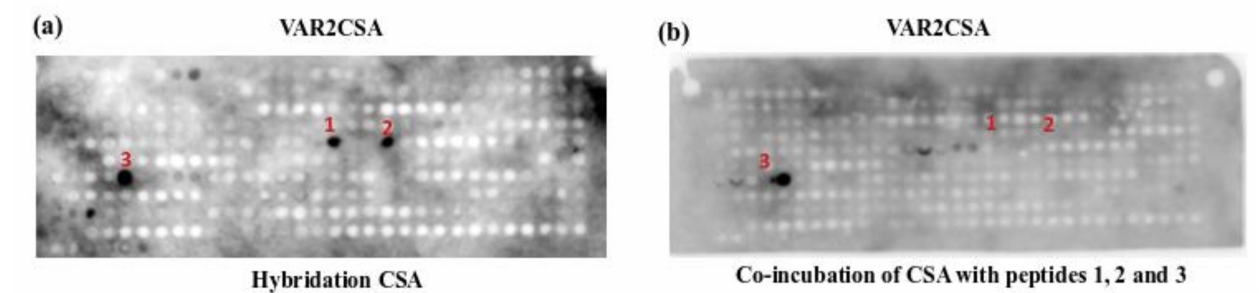
Figure 2. Identification of binding site of CSA to VAR2CSA. ( a ) VAR2CSA membrane hybridized with CSA. ( b ) Competition of the CSA binding to